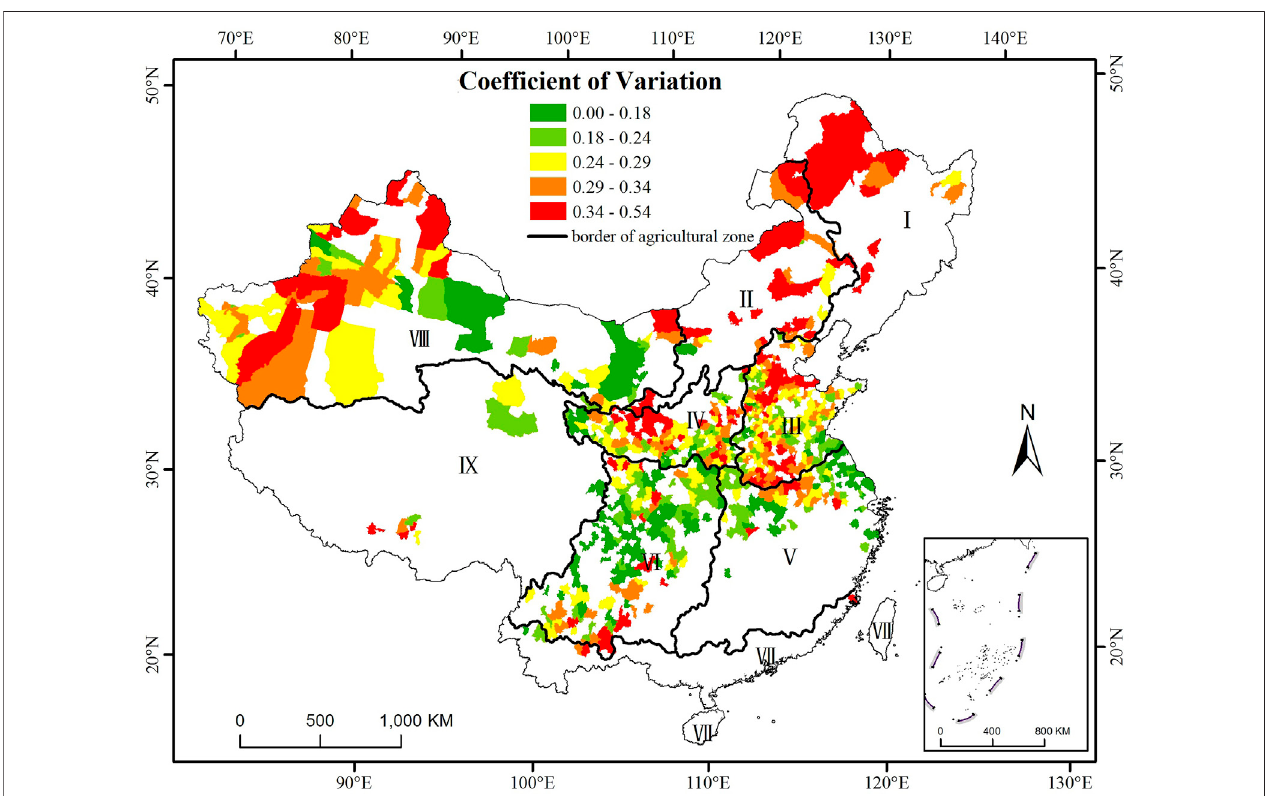
FIGURE 3 | Distribution of coef fi cient of variation of wheat for main production area in mainland of China from 1981 to 2010.